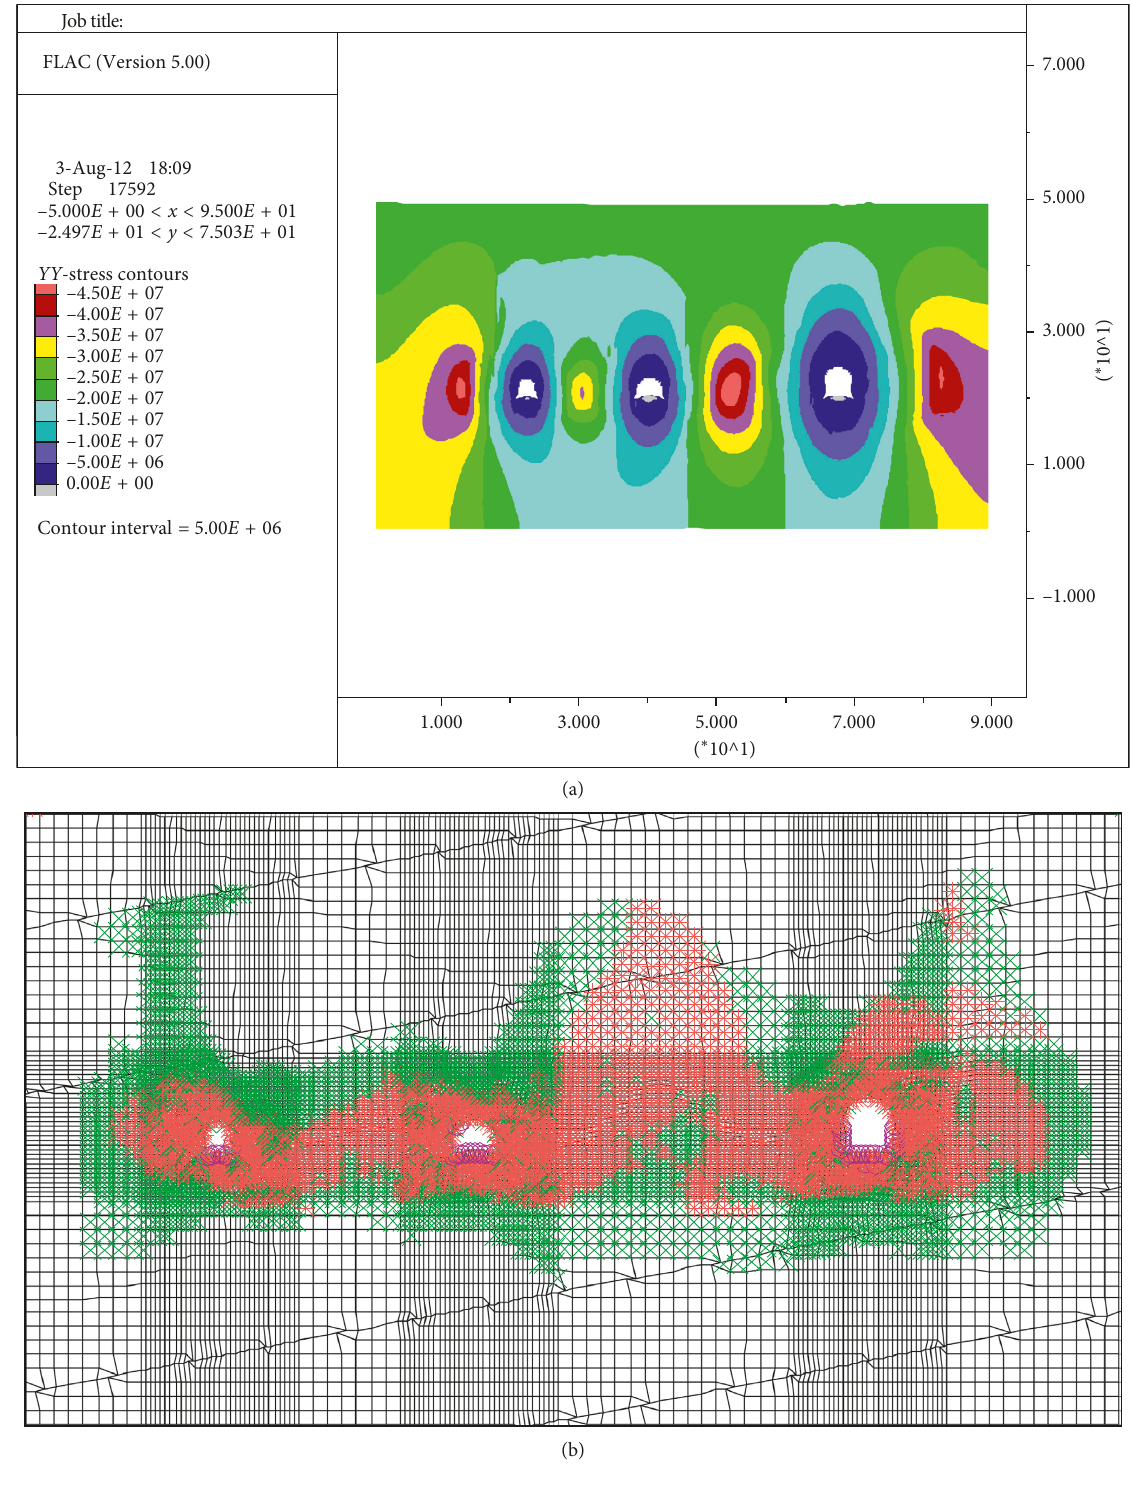
Figure 7: Calculation results of the excavation of the waiting room, main haulageway, and water pump house at the same time: (a) vertical stress of surrounding rock; (b) plastic zone of surrounding